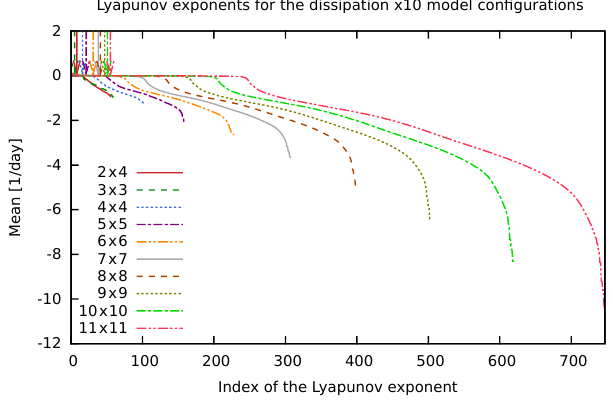
Figure 14. Lyapunov spectra of MAOOAM for the “dissipa- tionx10” experiment. Colours and arrows as in Fig.